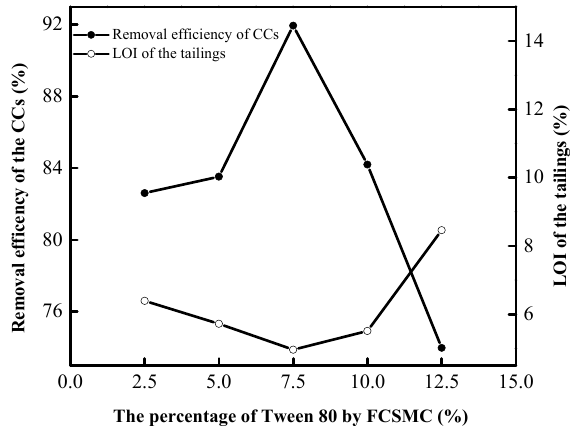
Figure 6. Effect of Tween 80 on decarburization by FCSMC: kerosene = 3.5 g/kg·ash, MIBC = 0.2 g/kg·ash, slurry concentration = 100 g/L, and pump speed = 380 r/min.